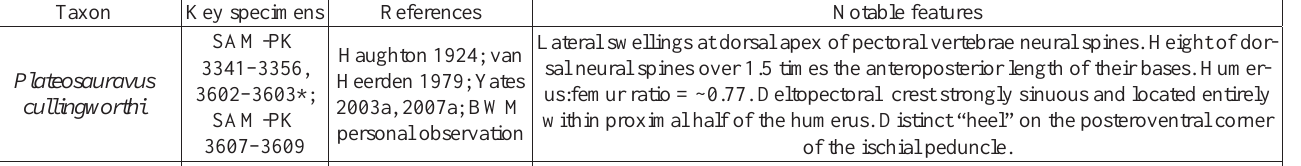
Table 3. Distinguishing characteristics of lower Elliot Formation sauropodomorph taxa (note that these are not intended as formal diagnoses). Asterisk denotes